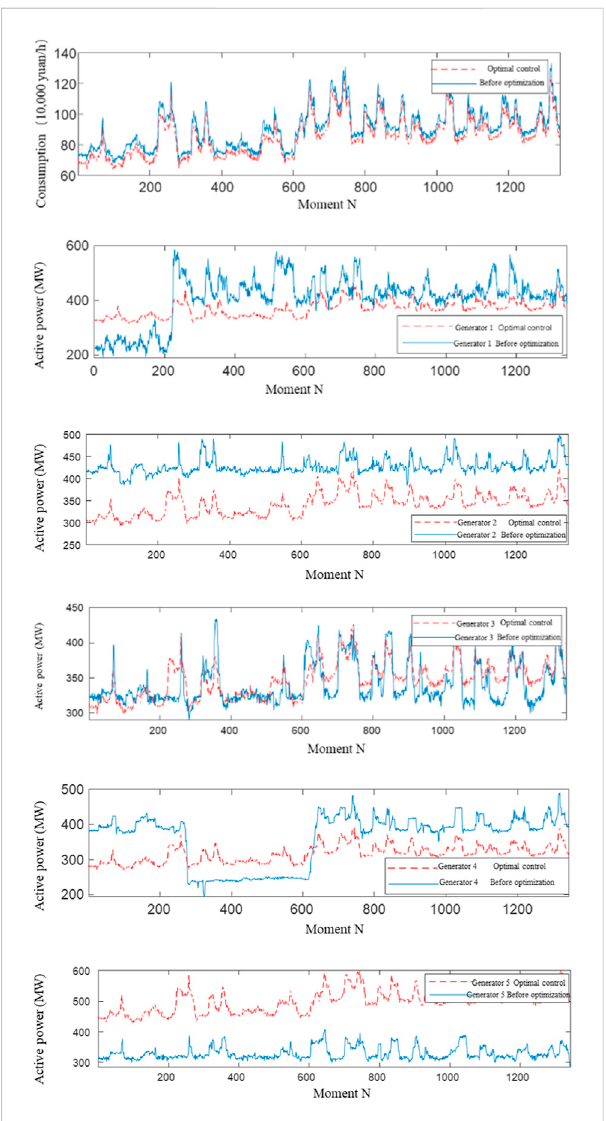
FIGURE 6 AI dispatching schemes at the different load levels under lumped load case.